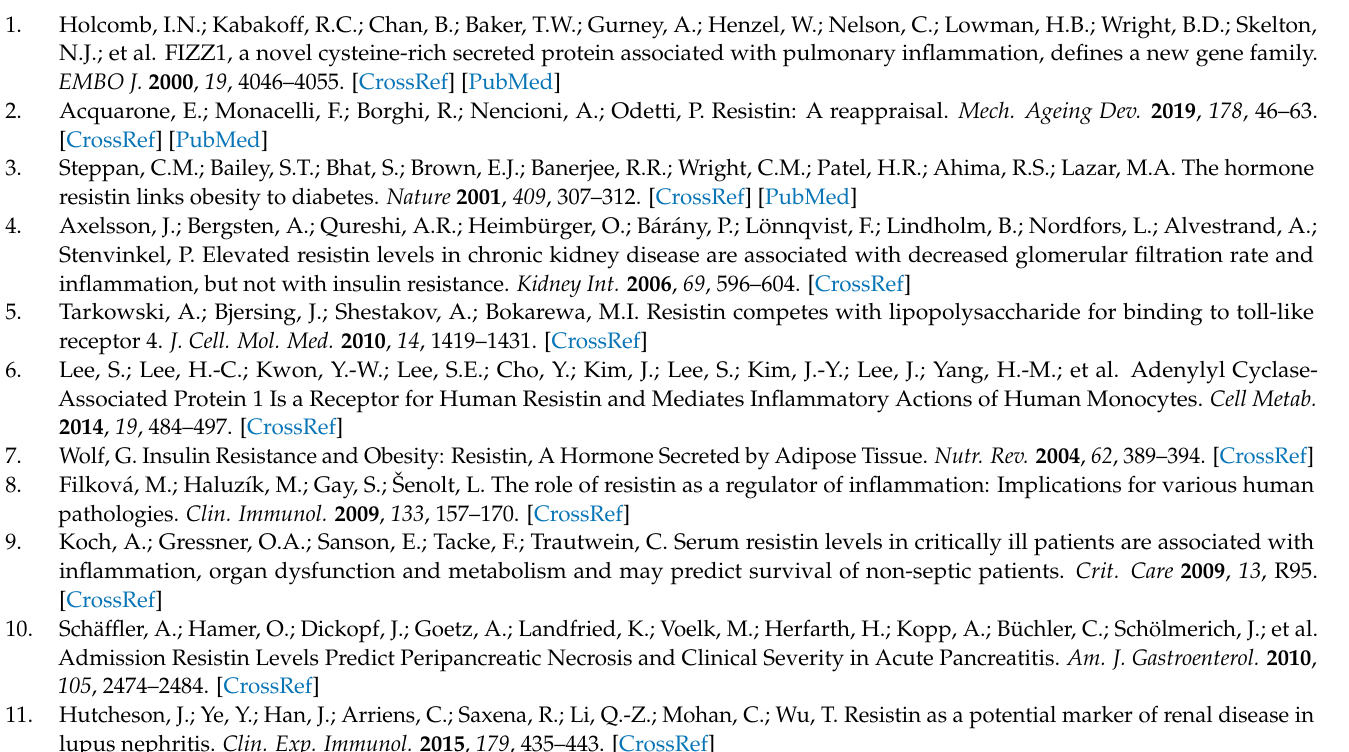
Table S3: Scenario 2 version of the Table 2 from the main body of the manuscript; Table S4: Scenario 2 version of the Table 3 from the main body of the